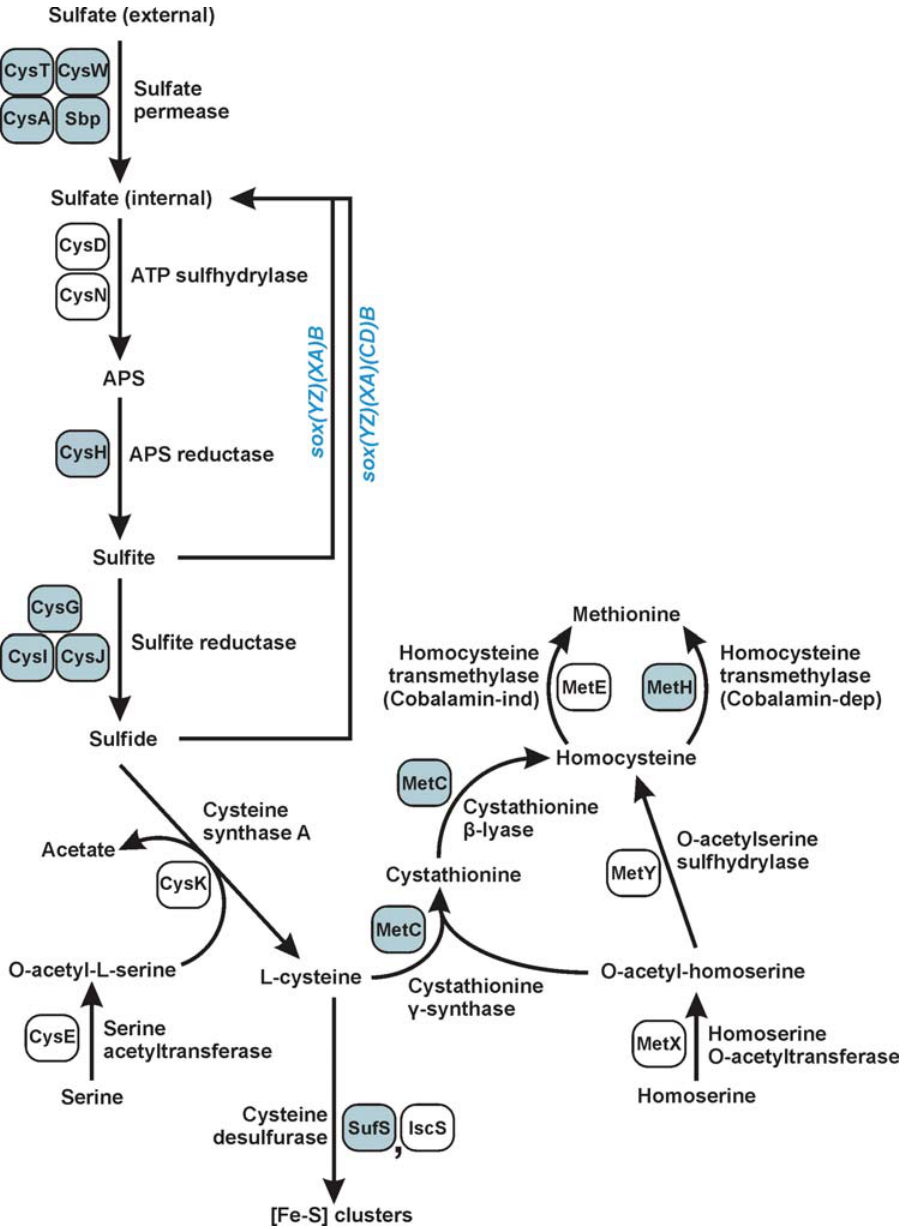
Figure 2. Sulfur assimilation and biosynthesis of the sulfur-containing amino acids. Genes/proteins in strain RM4018 unique within Campylobacteraceae or proteins with Campylobacteraceae orthologs of low similarity are labeled/shaded in blue.